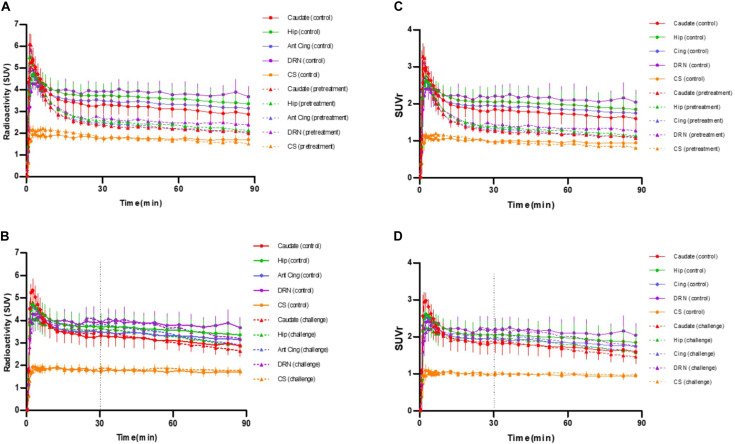
(A) Averaged time-activity curves of [18F]F13640 ± SEM (circles, control conditions; triangles, pretreatment study with a pre-injection of 1 mg/kg of d-fenfluramine, 30 min before PET acquisition). (B) Averaged time-activity curves of [18F]F13640 ± SEM (circles, control conditions; triangles, challenge study with a post-injection of 1 mg/kg of d-fenfluramine, 30 min after beginning of PET acquisition). (C) Averaged SUVr of [18F]F13640 ± SEM (circles, control conditions; triangles, pretreatment study with a pre-injection of 1 mg/kg of d-fenfluramine, 30 min before PET acquisition). (D) Averaged SUVr of [18F]F13640 ± SEM (circles, control conditions; triangles, challenge study with a post-injection of 1 mg/kg of d-fenfluramine, 30 min after beginning of PET acquisition) Caudate, caudate putamen; Hip, hippocampus; Cereb, cerebellum; Ant Cing, anterior cingulate cortex; DRN, dorsal raphe nucleus; CS, centrum semiovale.